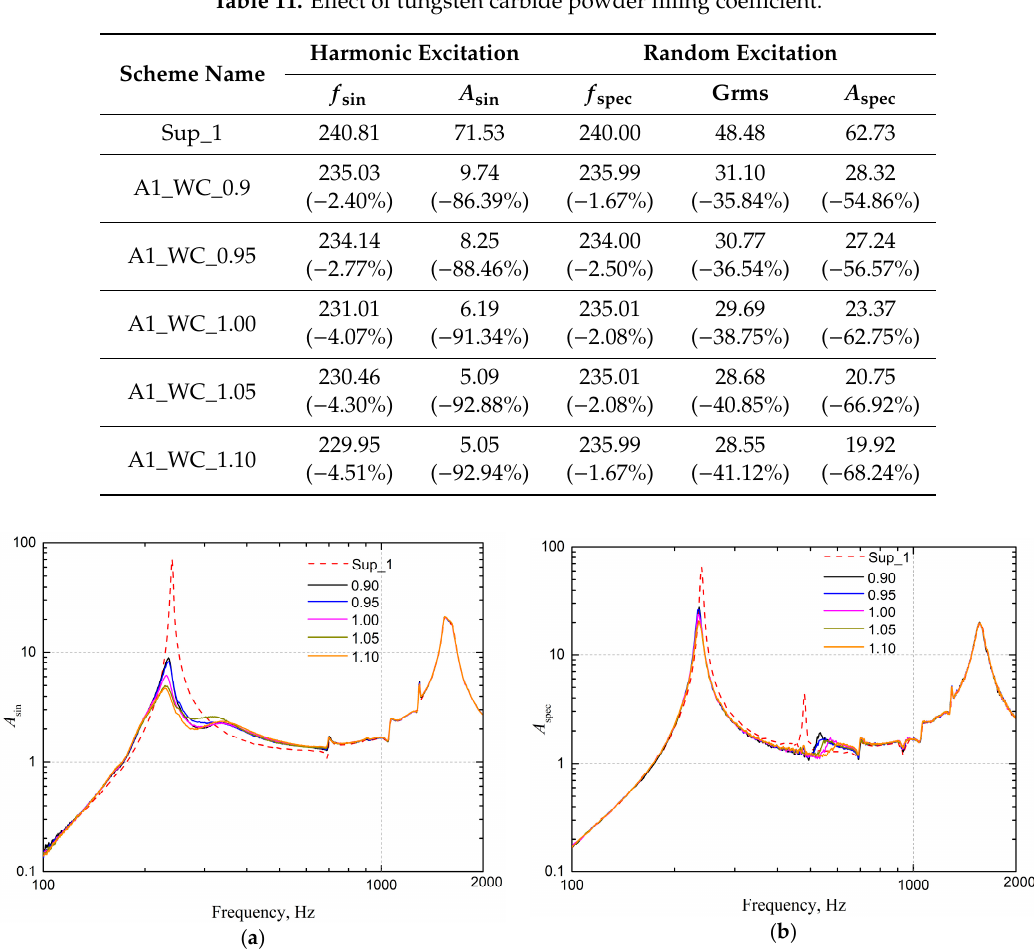
Figure 17. The effect of the filling coefficient on the experiment results: ( a ) Sinusoidal excitation; ( b ) Figure 17. The e ff ect of the filling coe ffi cient on the experiment results: ( a ) Sinusoidal excitation; Random excitation. ( b ) Random